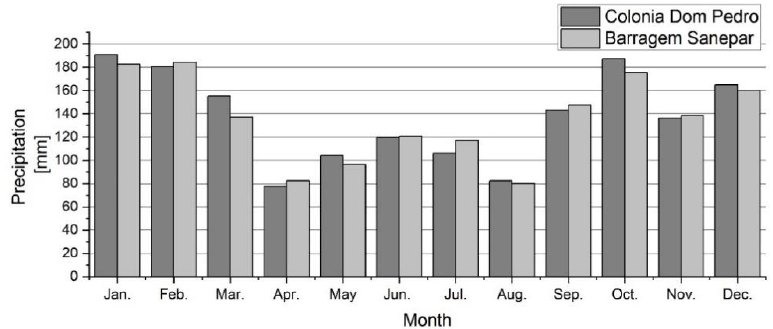
Figure 5. Monthly precipitation for the two locations in the Passaúna catchment. Figure 6. Monthly precipitation for the two locations in the Passa ú na catchment.